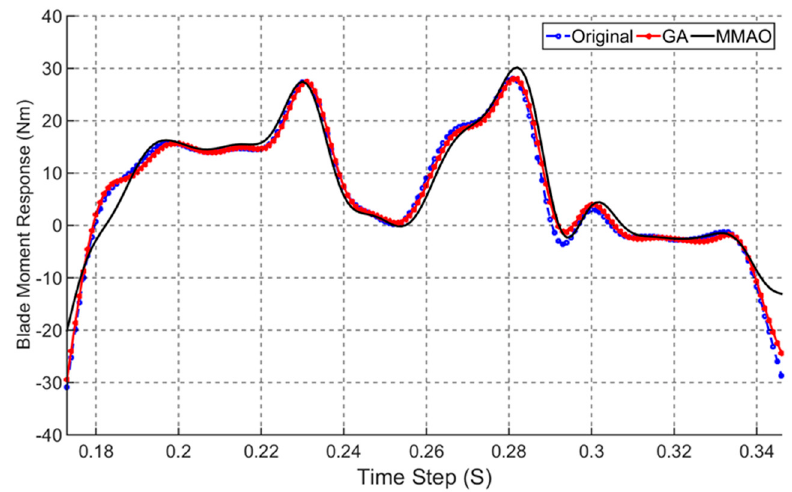
Figure 16. Moment responses from the single blade surfaces (1).